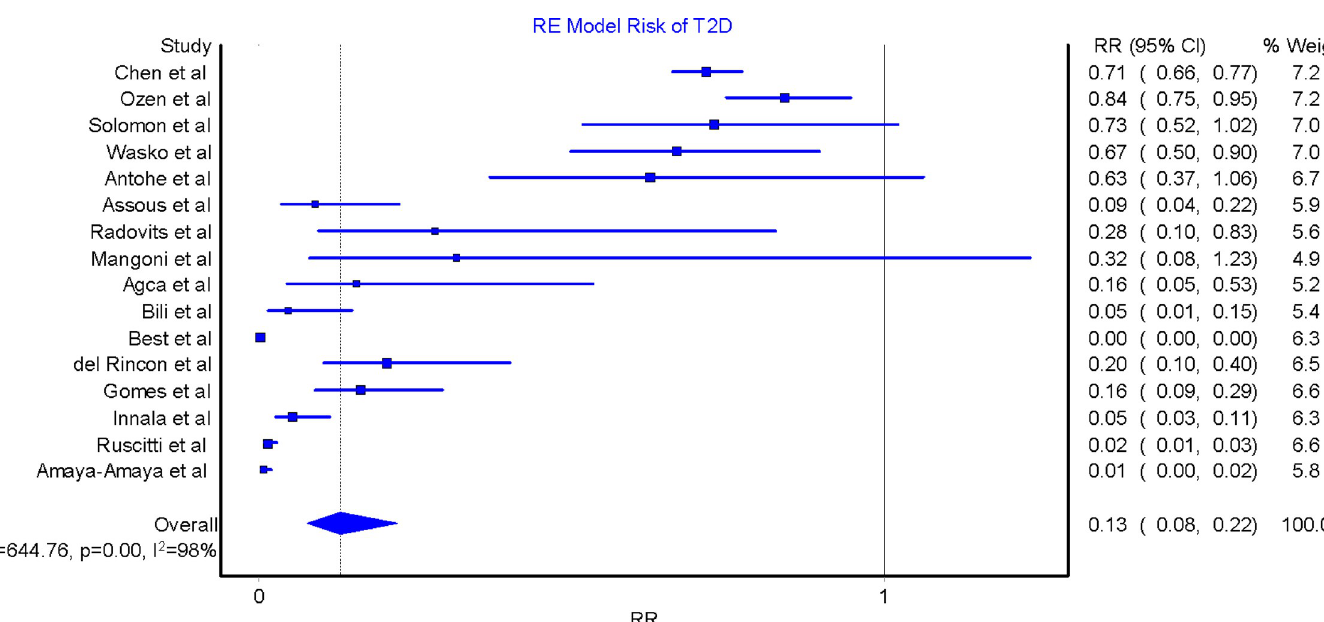
PLOS ONE | https://doi.org/10.1371/journal.pone.0235637 July 6,